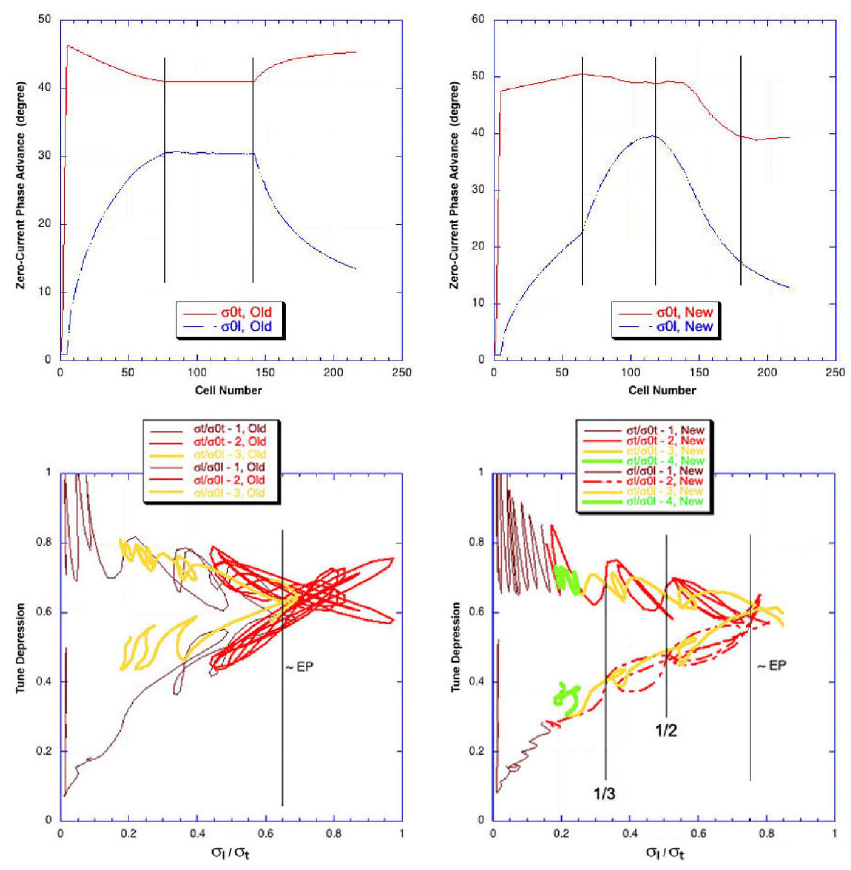
FIG. 4. (Color) Variation of the zero-current phase advances (upper) and Hofmann stability charts of the PKU deuteron RFQ (bottom) (left: before optimization; right: after optimization).